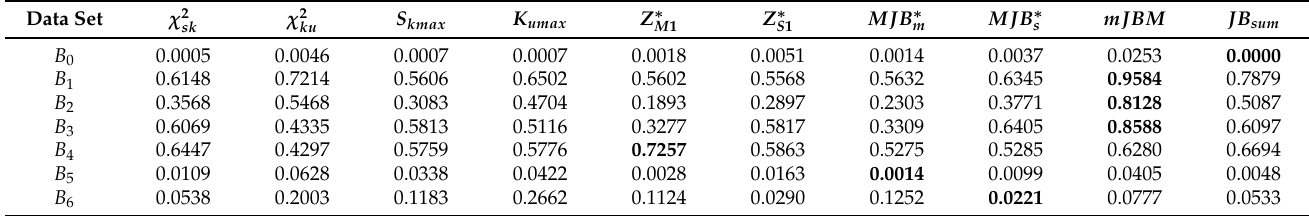
Table 8. p -values of the ten statistics of body